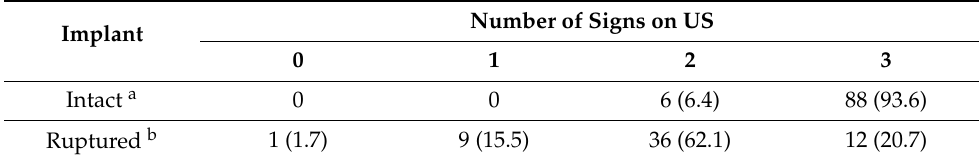
Table 4. Distribution of intact and ruptured implants by the number of signs of an intact and a ruptured implant on